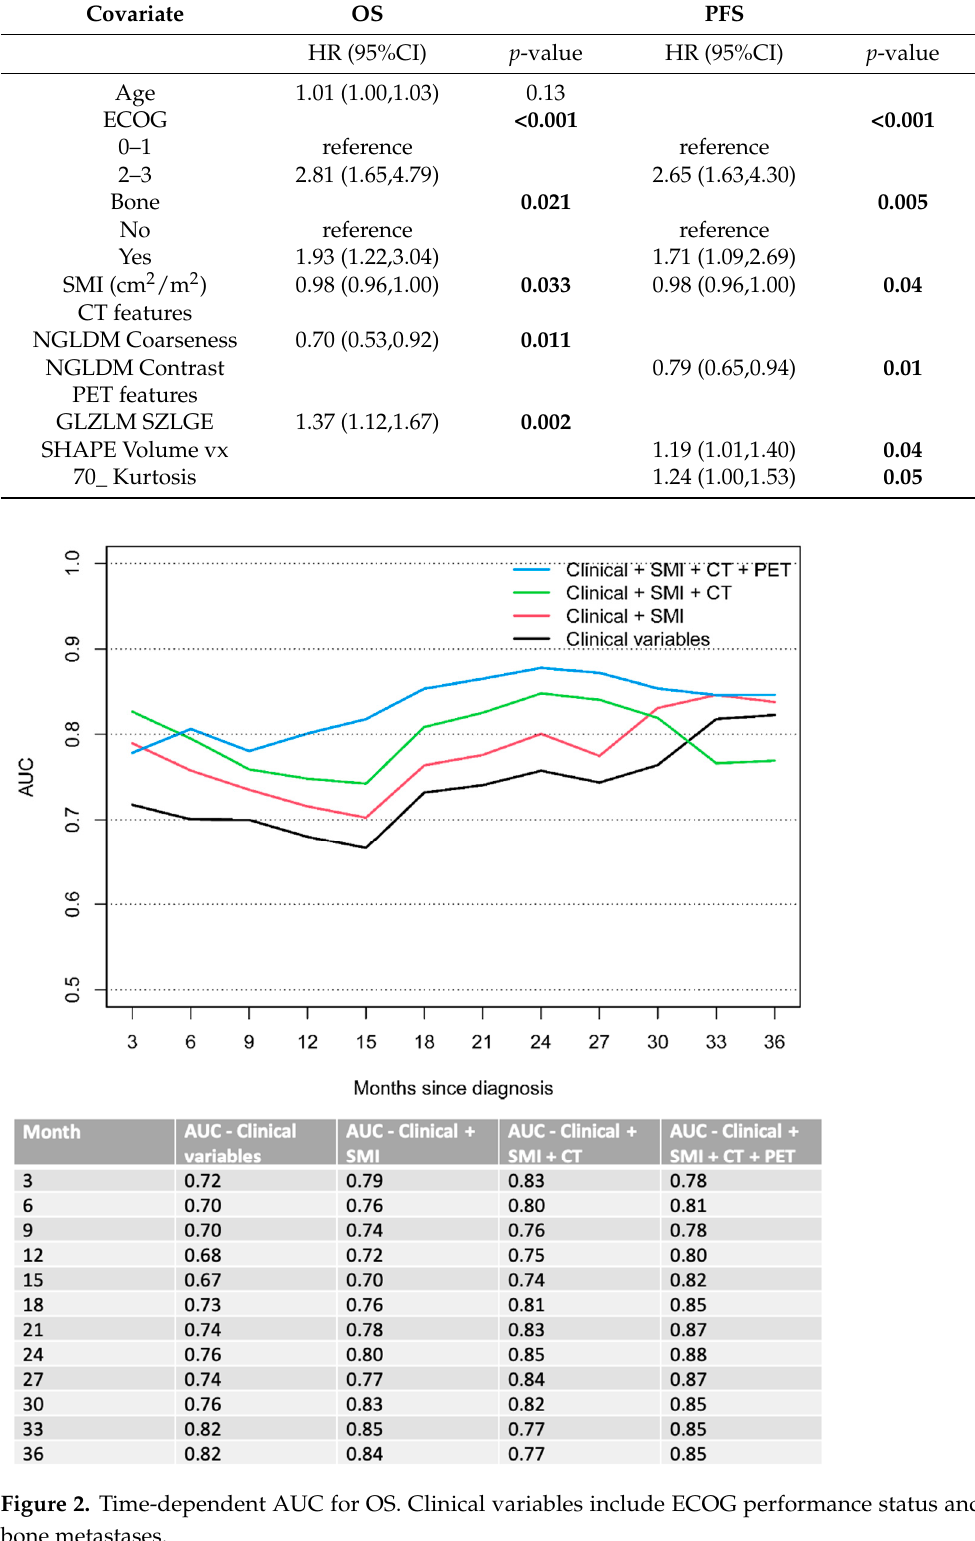
Table 3. Multivariable Cox regression analysis for OS and PFS in the overall cohort.